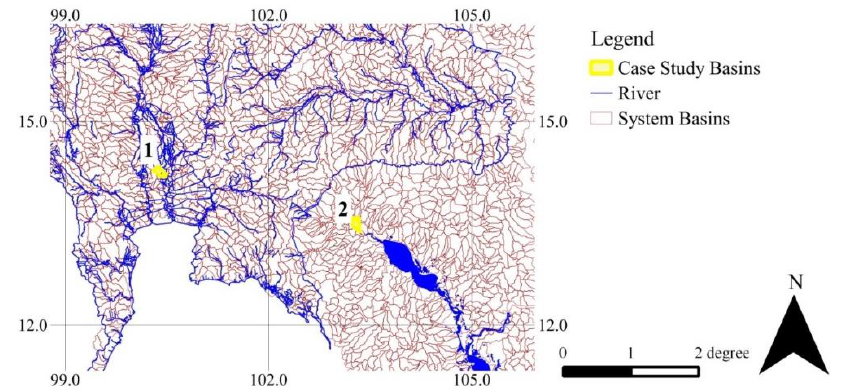
Figure 12. The two case-study basins: ( a ) just upstream of Bangkok near the Chao Phraya River (31245), and ( b ) upstream of the Tonle Sap Lake in Cambodia